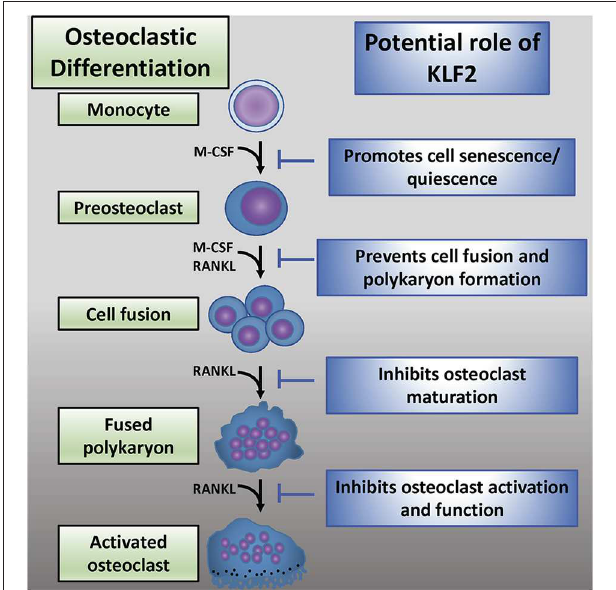
FIGURE 4 | The emerging role of KLF2 in osteoclastic regulation. Osteoclastic differentiation from myeloid precursor cells is critically regulated by M-CSF and RANKL ( 2). KLF2 may play an inhibitory role at several stages of osteoclastic differentiation, maturation, and activation